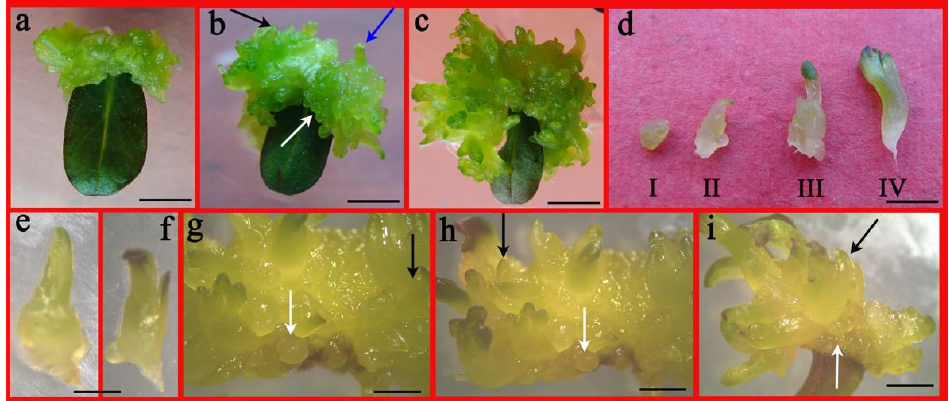
Figure 2. In vitro shoot regeneration and embryo-like structures (ELSs) induction from A. lupulina leaf explants on MS medium supplemented with 3.0 mg L − 1 of TDZ and 0.1 mg L − 1 of NAA. ( a ) Formation of callus following a 3-week culture. ( b ) Appearance of adventitious shoots (blue arrow) and some ELSs (in globular (white arrow) and torpedo shapes (black arrow)) on the leaf explant surface following culture for 4 weeks. ( c ) prolific adventitious shoots following 5 weeks of culture. ( d ) ELSs stages, globular- (I), torpedo-(II) and cotyledonary embryo (III,IV). Torpedo-( e ) and cotyledon- ( f ) shaped embryo. ( g – i ) were amplified image of Figure 2b from different angles, the white arrow is indicative of ELSs globular-shaped embryo, the black arrow is indicative of torpedo-shaped embryo. Bar = 5 mm ( a ), 3 mm ( b , c ), 5 mm ( d ), 2 mm ( e , f ). The browning rate was conspicuously more for either BA alone or with 0.1 mgL − 1 NAA, (between 70.2 to 75.4%) as opposed to TDZ treatment only (ranged from 25.5–32.5%). Interestingly, the leaf explants turned brown but displayed no necrosis and sustained high regeneration capacity. The development of ELSs and enumeration of regenerated shoots were documented. The numbers of adventitious shoots and ELSs were more for the BA (4.0 mg L − 1 ) and NAA (0.1 mg L − 1 ) combination at 13.5 and 8.7, respectively, versus only BA (7.8 shoots and 4.7 somatic embryos, respectively) (Table 2). A light-green callus was induced on the cut surface of the enlarged and browning leaf in 3 weeks (Figure 3a). Later, the formation of few shoots (Figure 3b blue arrow) and a protuberance (globular-shaped, Figure 3b, white arrow) were detected on the callus in the subsequent culture period. Extending the culture time resulted in the formation of adventitious shoots (Figure 3c blue arrow) on the callus surface and some globular- (Figure 3c white arrow; Figure